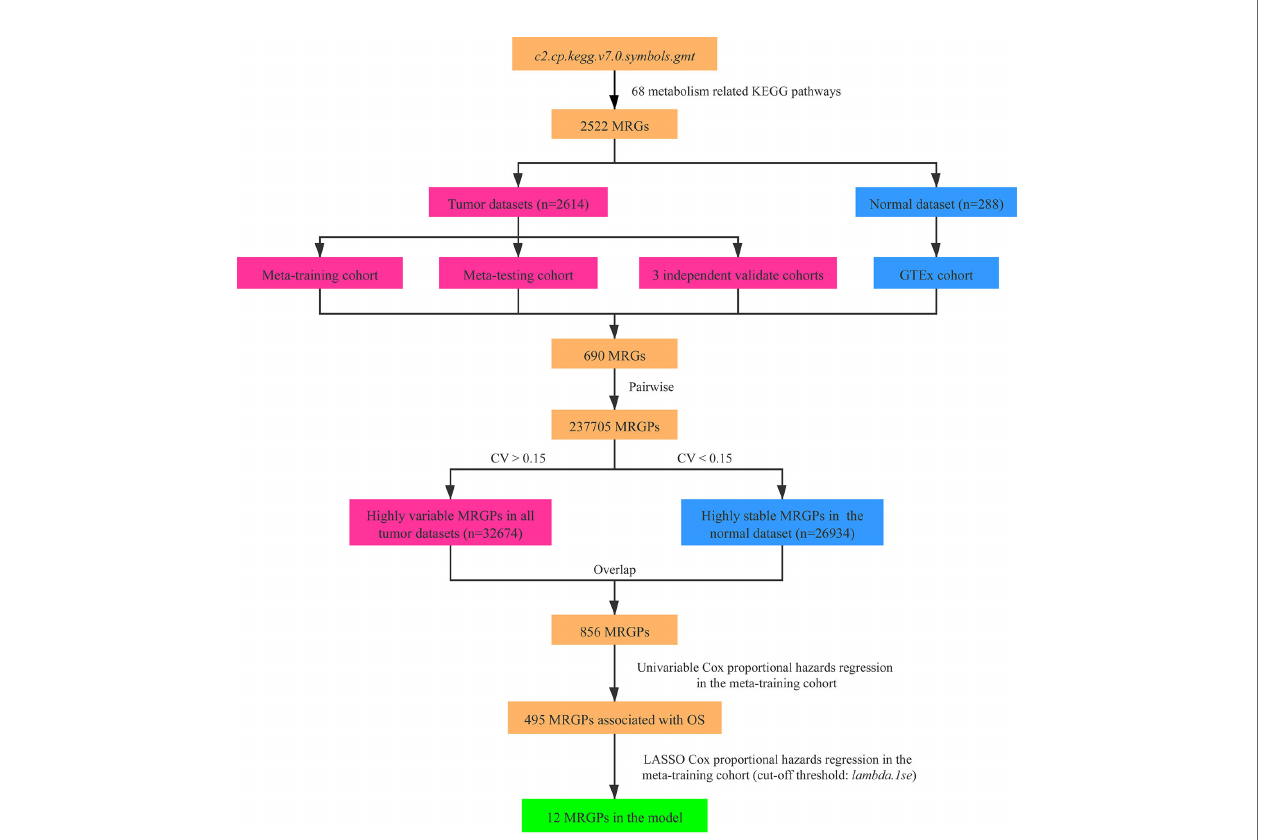
FIGURE 1 | Flowchart of the construction process of MRGPI. CV, coef fi cient of variation; GTEx, the Genotype-Tissue Expression; LASSO, least absolute shrinkage and selection operator; MRGs, metabolism-related genes; MRGPs, metabolism-related gene pairs; OS, overall